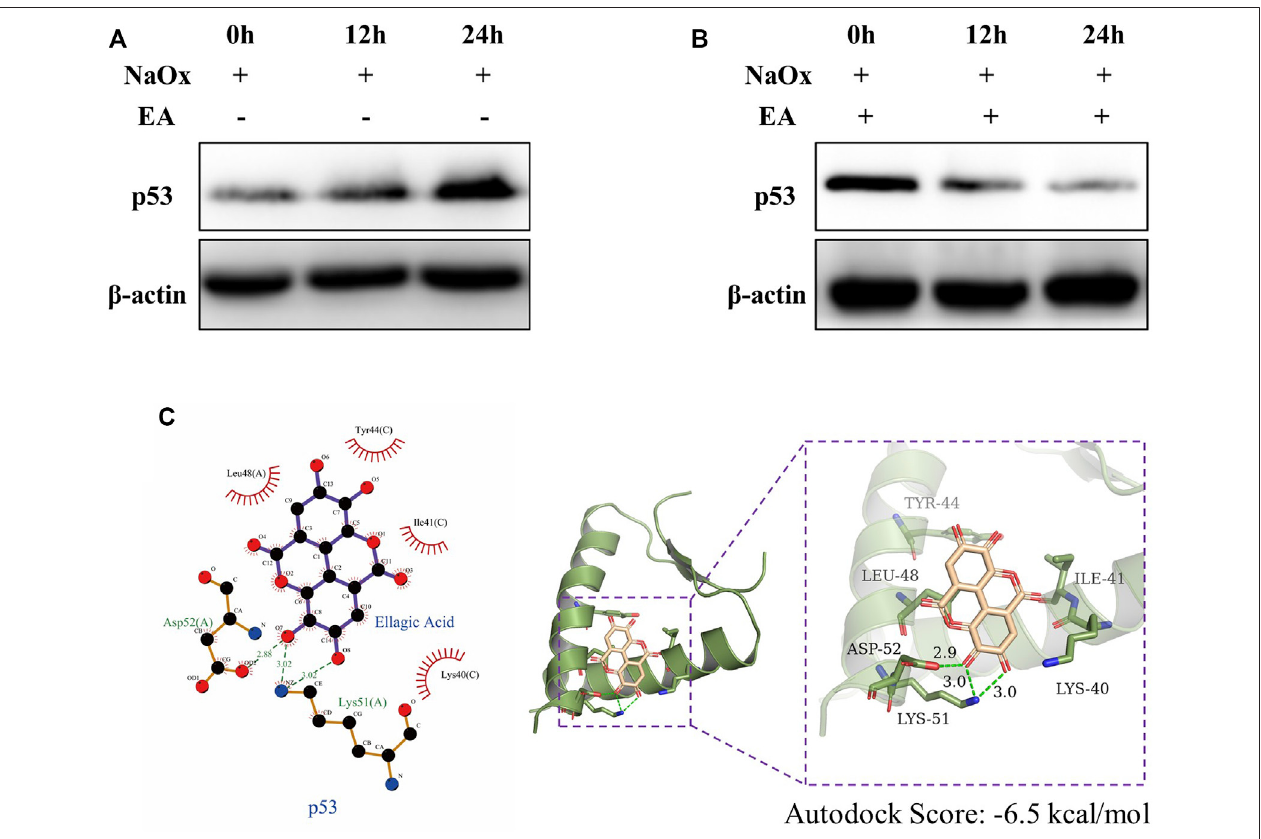
FIGURE6| Ellagicacidreducestheexpressionofp53 (A) Expressionofp53proteinwasdetectedbywesternblotinthesodiumoxalategroup(NaOx)at0,12,and 24 h (B) Expressionofp53proteinwasdetected byWesternblotintheellagic acidtreatmentgroup(NaOx+EA)at0,12,and 24 h (C) Two-dimensional(left)and three- dimensional (right) ligand interaction diagrams of ellagic acid and the original ligands of p53.